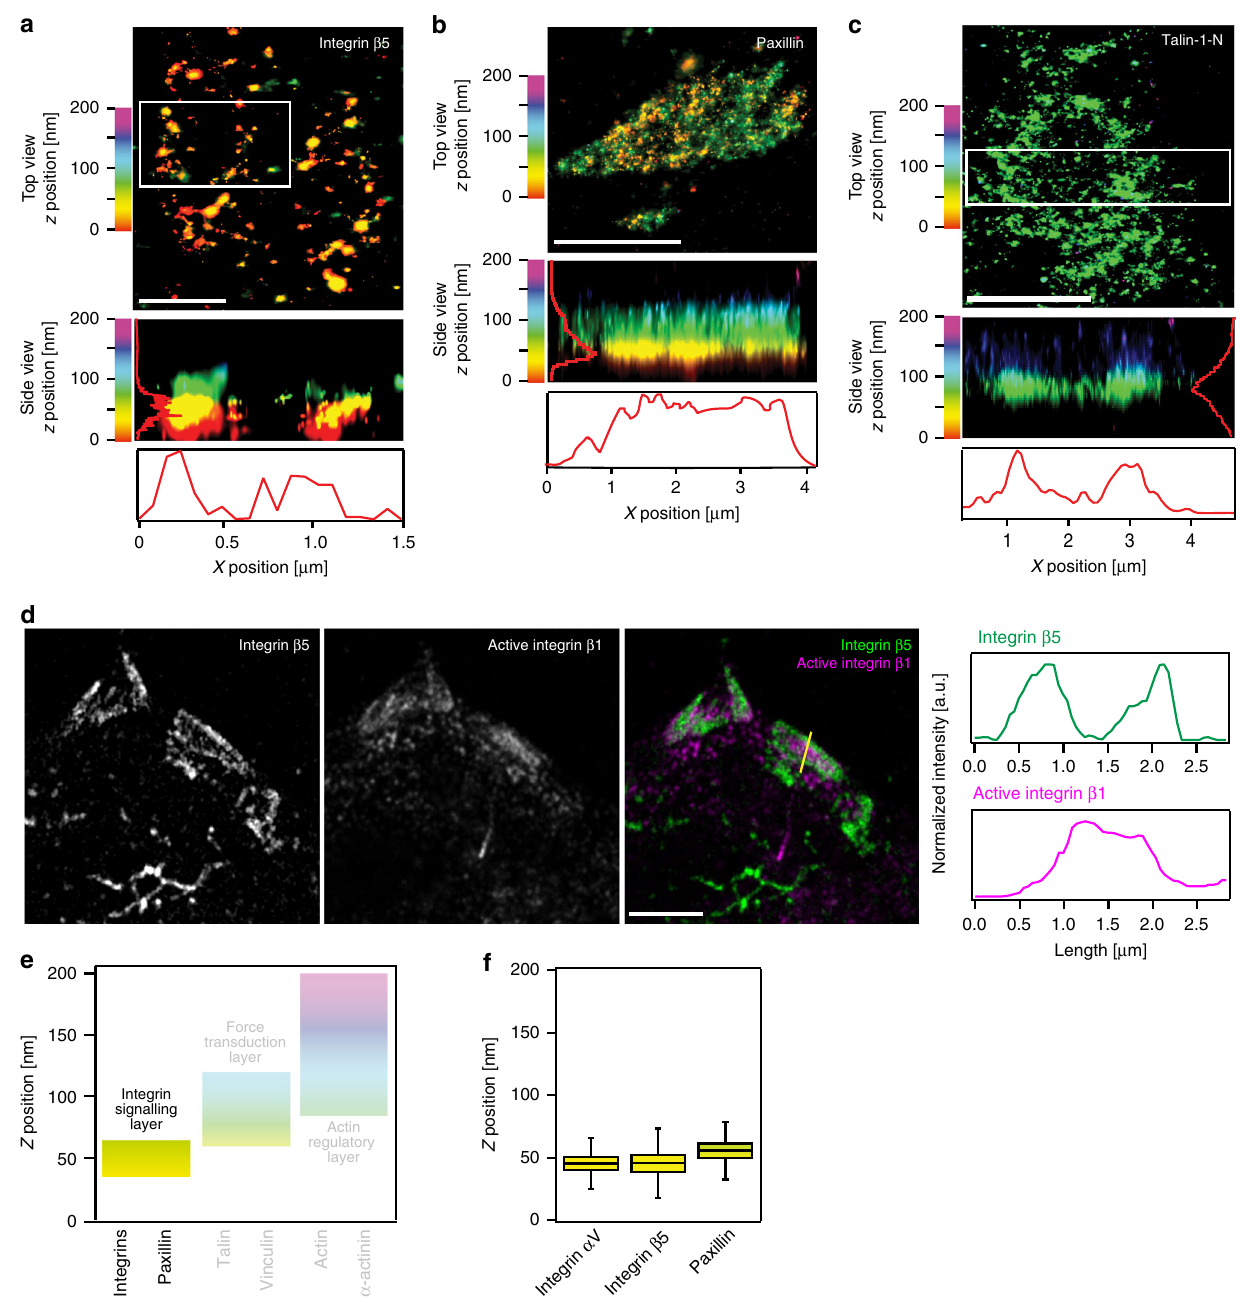
Fig. 3 Lateral and vertical segregation of proteins within cornerstone FA. a – c Interferometric photo-activated localisation microscopy (iPALM) images of Eos-tagged integrin β 5 ( a ), paxillin ( b ), and talin-1-N (N-terminally tagged talin-1) ( c ) in cornerstone FA. Individual cornerstone FA are displayed. Both top- view ( xy ) and side-view ( xz ) images are displayed. White boxes indicate the area used to generate the side-view images (in the absence of a white box, the entire image was used). For all images, individual localisations are colour-coded as a function of their z -positioning (distance from the coverslip). In addition, normalised line intensity pro fi les of the region of interest, in both z - and x -axis, are shown in red lines. d hPSC plated for 24 h on VTN were stained for endogenous integrin β 5 and active integrin β 1 (mAb 12G10) and imaged using an Airyscan confocal microscope. The yellow line highlights the area used to measure the intensity pro fi les displayed on the side. Scale bars ( a ) 1 μ m, ( b , c ) 2 μ m, ( d ) 5 μ m. e Schematic representation of the different FA layers previously identi fi ed using iPALM in U2OS cells 13 , colour bars highlight the z range for each of the three layers and the integrin signalling layer is emphasised over other layers. f iPALM analysis of the z position (distance from the coverslip, Z centre ) of some of the integrin signalling layer components, Eos-tagged integrins α V ( n = 17 biologically independent ROI. Given that cornerstone FAs are clusters of FAs, one ROI may contain multiple FAs. For details on the number of localisations, and HPSC colonies see supplementary Table 1) and β 5 ( n = 22 biologically ROI), and Eos-tagged paxillin ( n = 23 biologically independent ROI), in hPSC cornerstone adhesions. Boxes display the median, plus the 1st and 3rd quartiles (IQR: 25th – 75th percentile). Whiskers correspond to the median ± 1.5 × IQR. Source data are provided as a Source Data fi